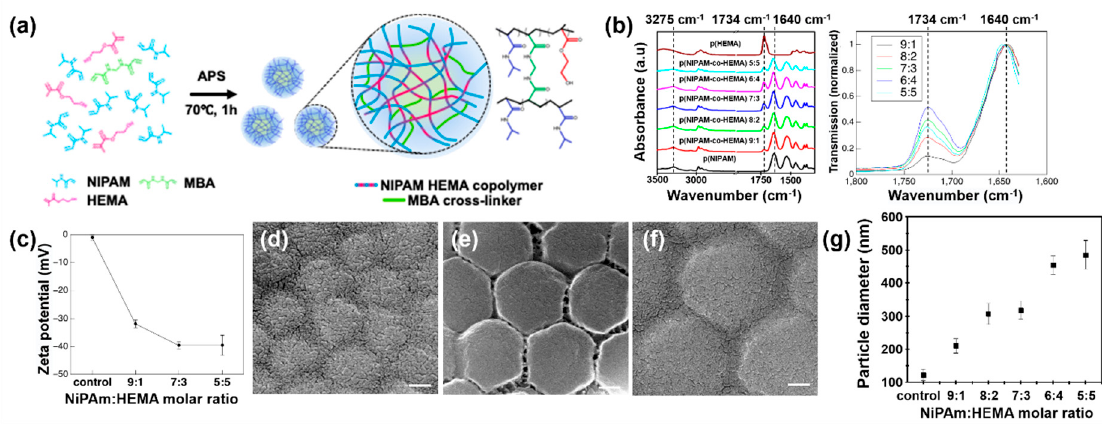
Figure 1. ( a ) Schematic illustration for the synthesis of p(NiPAm-co-HEMA) microgels. ( b ) Fourier-transform infrared spectroscopy (FTIR) data for p(HEMA) polymer, p(NiPAm), and p(NiPAm-co-HEMA) microgels with varying molar ratio between N-isopropylacrylamide (NiPAm) and 2-hydroxyethyl methacrylate (HEMA). For comparison of NiPAm and HEMA signal ratio among samples, normalized FTIR data are plotted for p(NiPAm-co-HEMA) microgels (right). ( c ) Zeta potential of p(NiPAm) and p(NiPAm-co-HEMA) microgels with varying NiPAm:HEMA molar ratio. ( d – f ) Scanning electron microscope (SEM) images of p(NiPAm-co-HEMA) microgels with molar ratios between NiPAm and HEMA of ( d ) 9:1, ( e ) 7:3, and ( f ) 5:5, respectively. Scale bar in ( d – f ) represents 100 nm. ( g ) Effect of molar composition of HEMA to particle diameter.